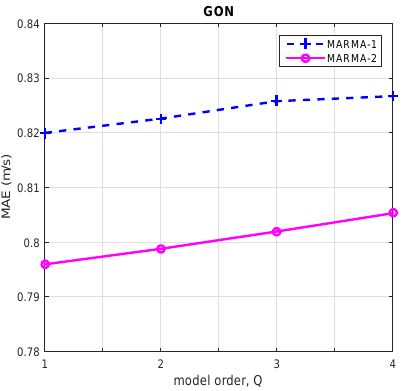
Figure 9. Mean absolute error (MAE) performances of the MARMA-1 and MARMA-2 models with respect to model order Q when m = 3 (GONEN) and ∆ = 2